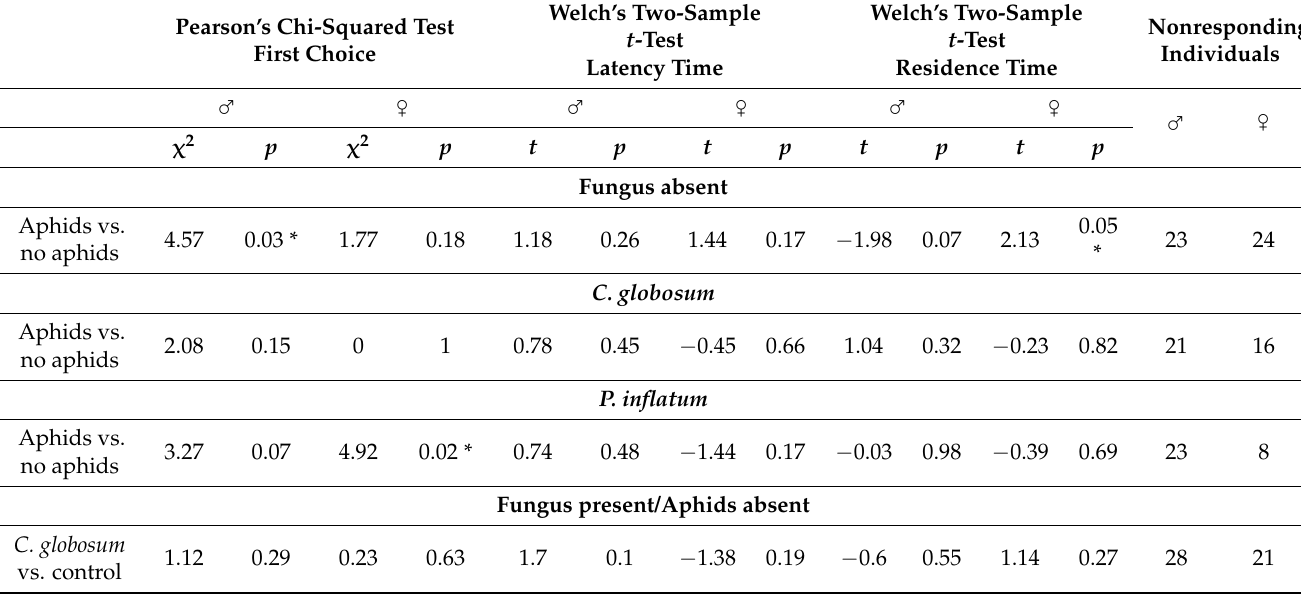
Table 1. Statistical analyses of the first choice, latency, and residence time in seconds for female and male Hippodamia convergens . Tests were conducted in a Y-tube olfactometer providing individuals with a choice between stimuli emitted by fungal-treated or untreated cotton plants in the presence or absence of aphids. Sample sizes for each comparison were N = 60 for each sex. * p ≤